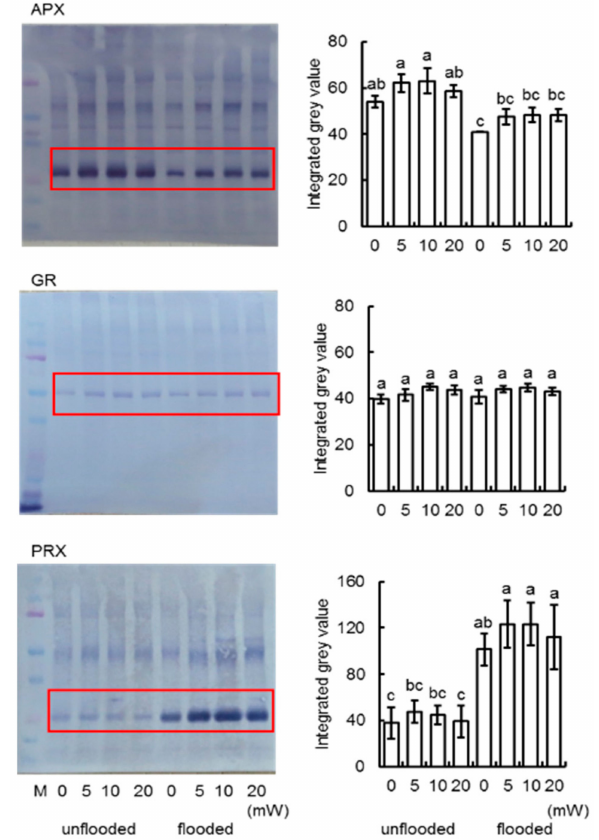
Figure 7. Immunoblot analysis of proteins involved in ascorbate / glutathione pathway. Proteins were extracted from soybean seedlings and separated on 10% SDS-polyacrylamide gel by electrophoresis and transferred onto membranes. The membranes were cross-reacted with anti-APX, anti-GR, and anti-PRX antibodies. CBB staining pattern was used as loading control (Figure S5). The integrated densities of bands were calculated using ImageJ software. Picture shows three independent biological replicates (Figure S6). Data are shown as the means ± SD from three independent biological